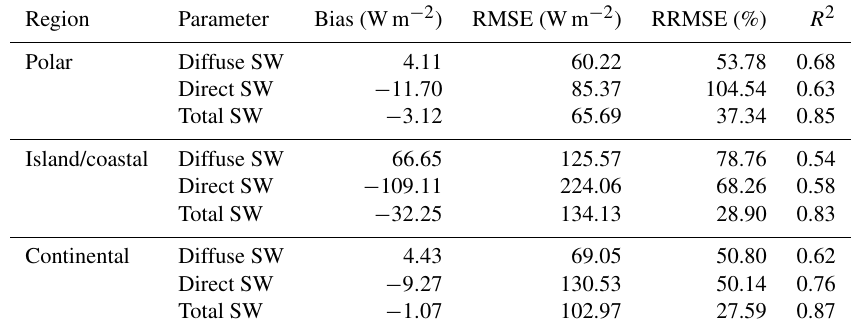
Table 1. Evaluation of EPIC-based hourly SW estimates against the ground-based measurements for different regions.